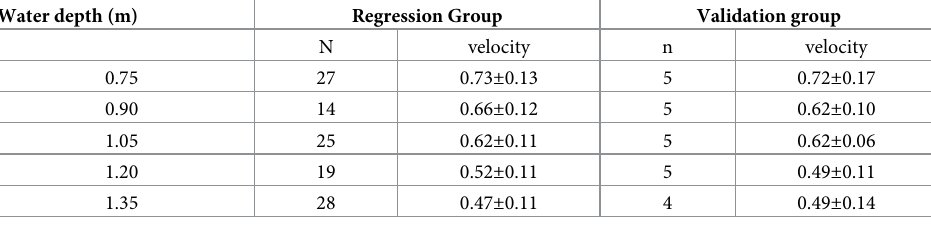
Table 2. Mean and standard deviations of gait velocity (m/s) at the different water depth levels for the validation and regression